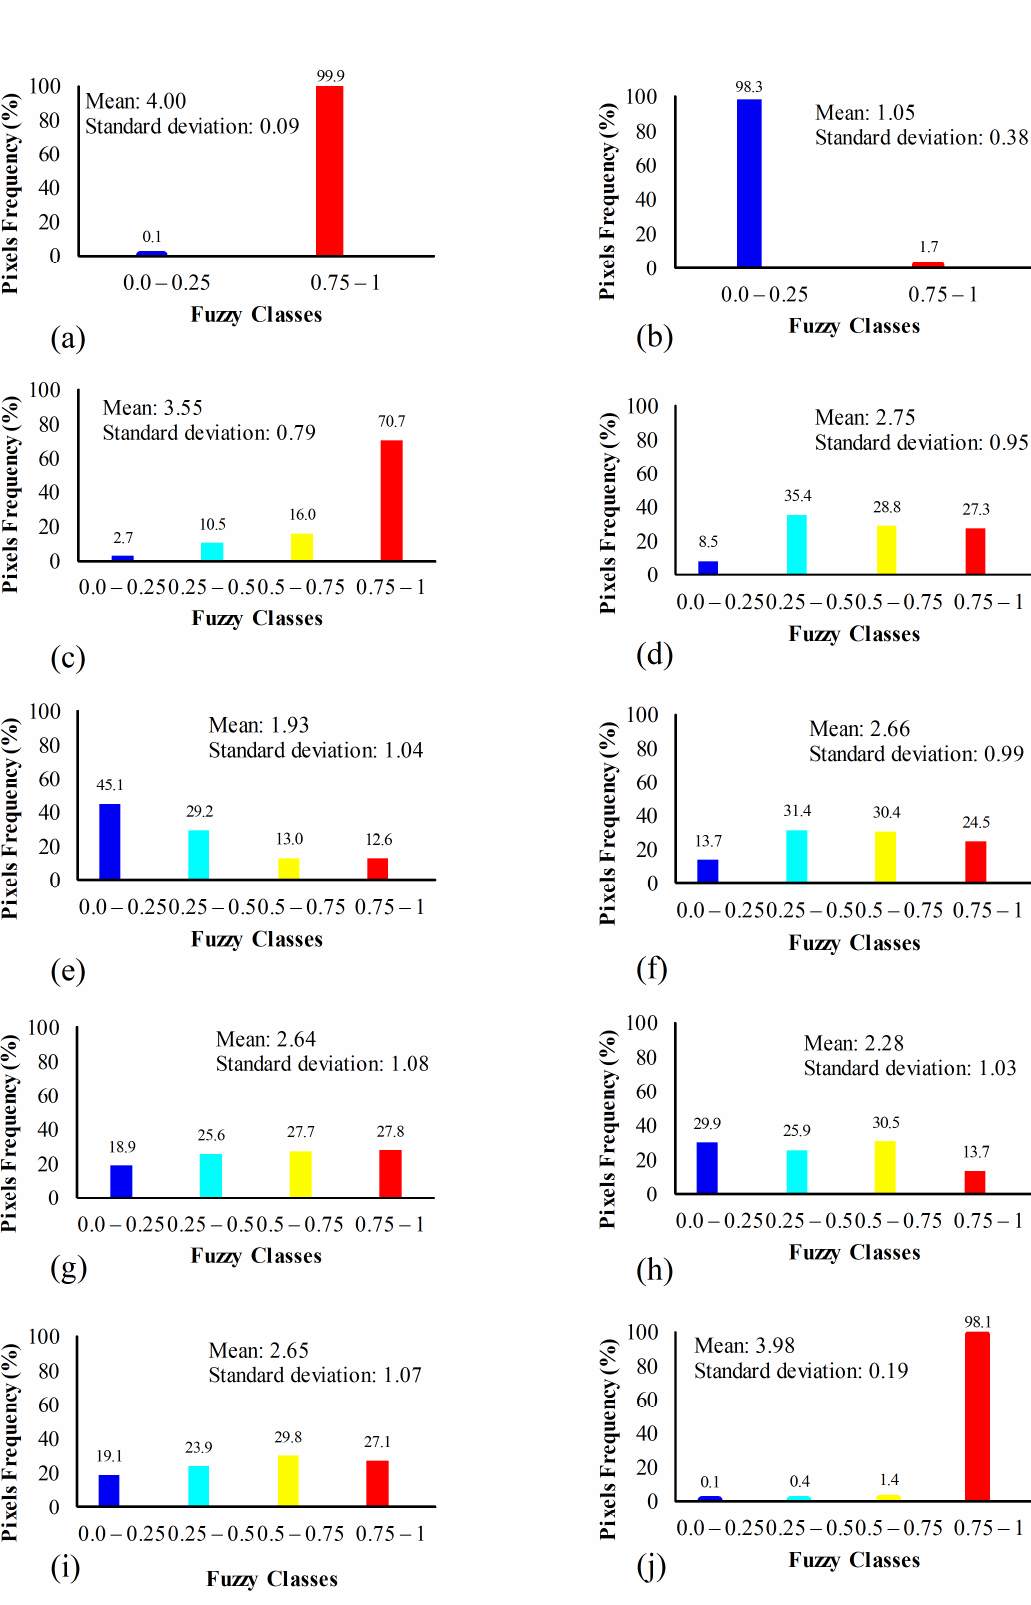
Figure 5. Pixels frequency for each fuzzy class. ( a ) Compactness coefficient; ( b ) slope; ( c ) Digital Elevation Model (DEM); ( d ) annual average maximum rainfall; ( e ) dry period average maximum rainfall; ( f ) rainy period average maximum rainfall; ( g ) annual accumulated rainfall; ( h ) dry period accumulated rainfall; ( i ) rainy period accumulated rainfall; ( j ) proximity to